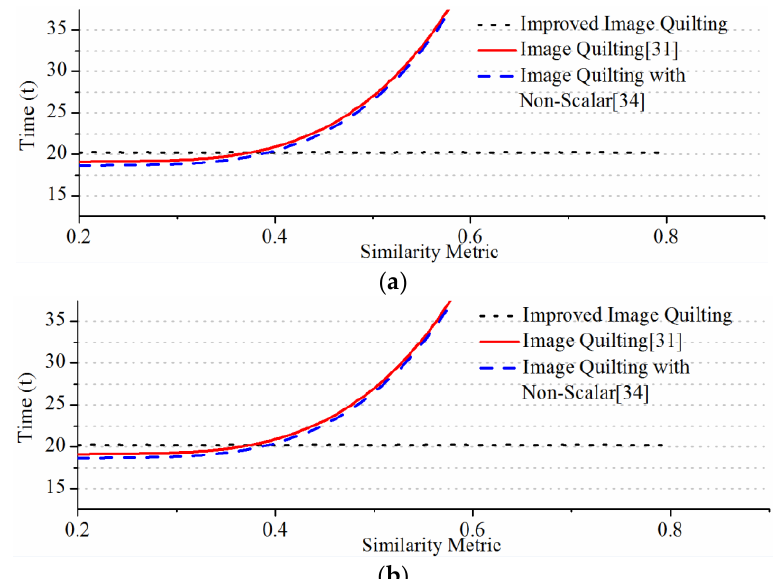
Figure 8. The mean synthesis time of lane in ( a ) and asphalt in ( b ) by the algorithm in [31,34], and by the improved Image Quilting in this study. The similarity metric along the horizontal axis is λ 0 .